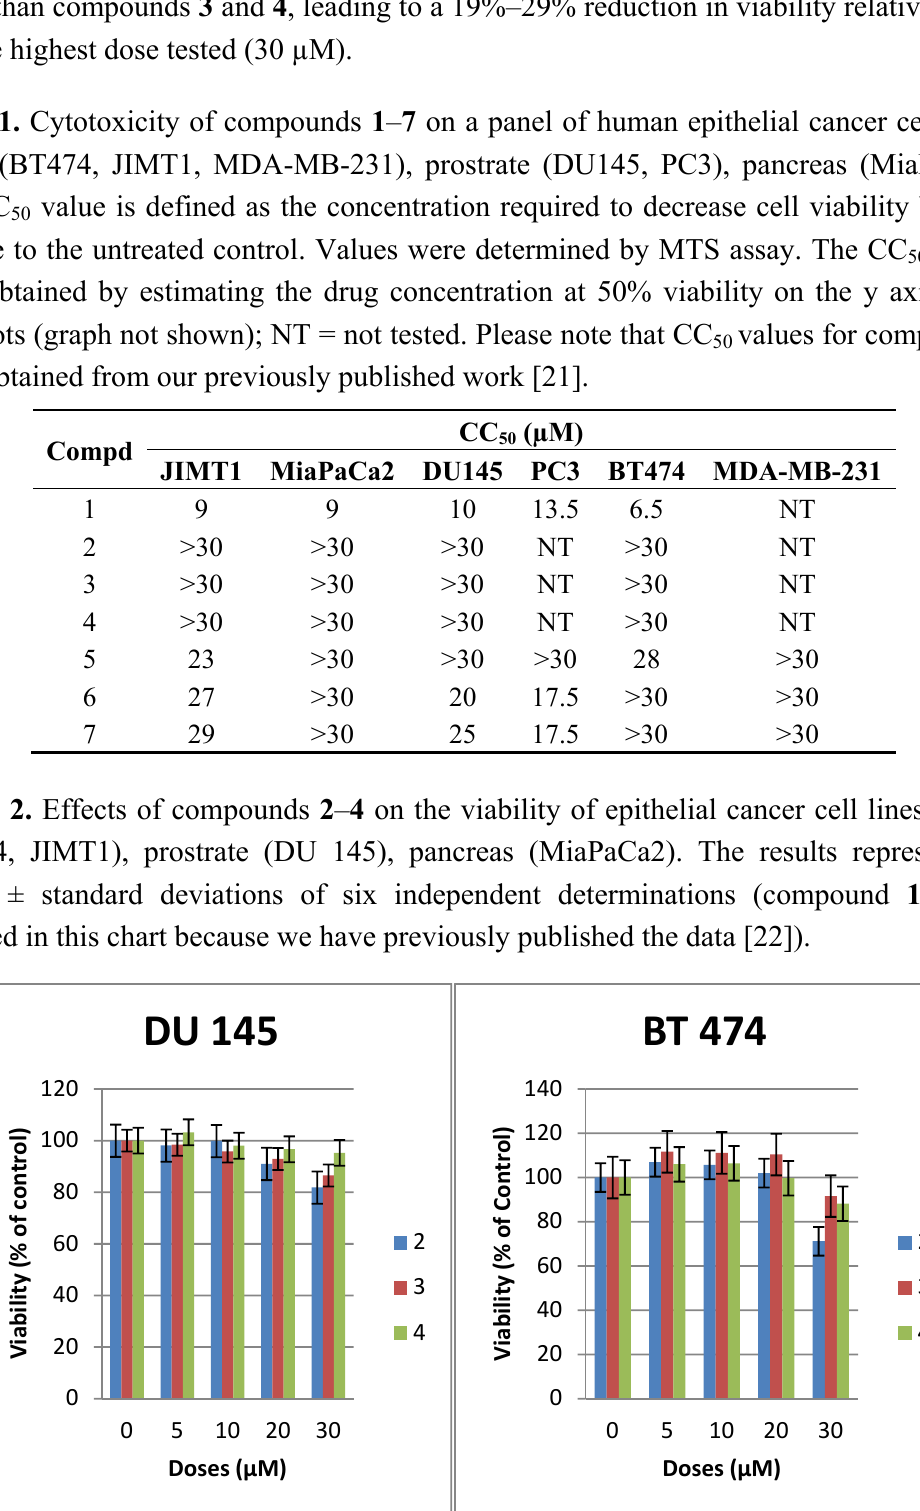
Table 1. Cytotoxicity of compounds 1 – 7 on a panel of human epithelial cancer cell lines: breast (BT474, JIMT1, MDA-MB-231), prostrate (DU145, PC3), pancreas (MiaPaCa2).